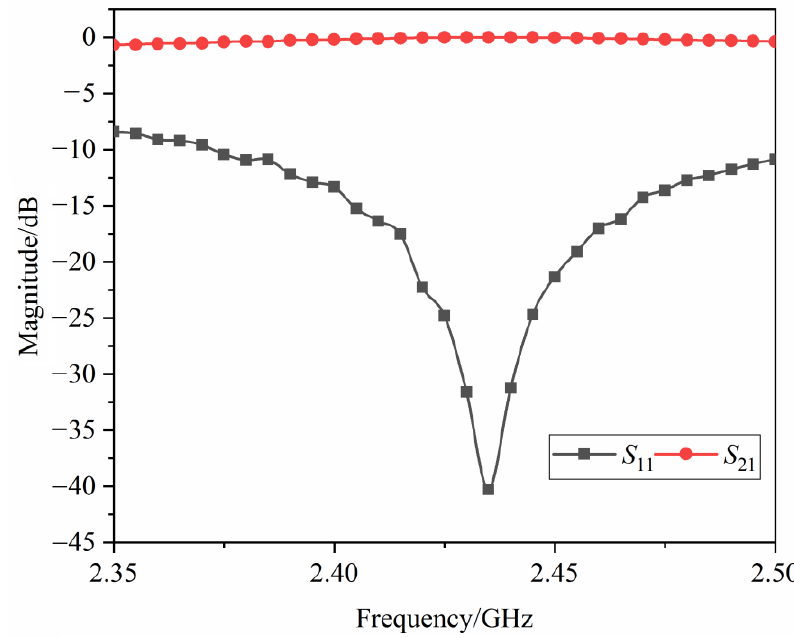
Figure 4. The S-parameters of the double-ridged waveguide.